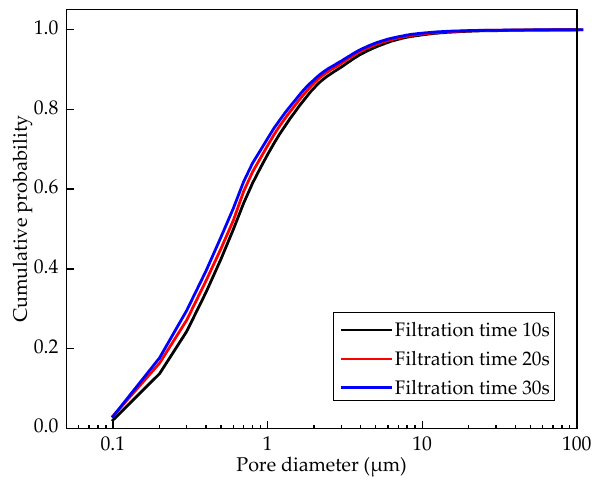
Figure 7. Pore diameter cumulative distribution curve of the filter cake pores at the different filtration times.